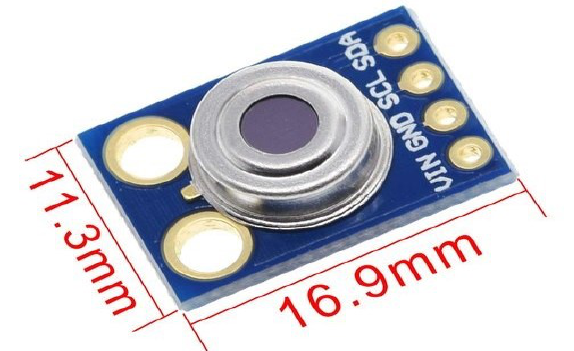
Figure 8. MLX90614 contact-free temperature measuring sensor.